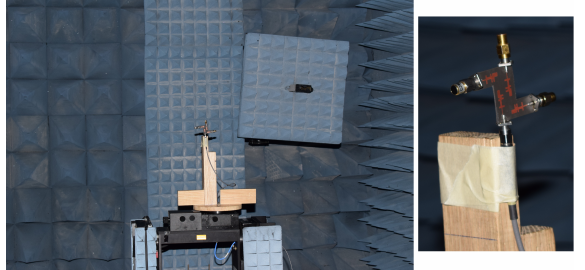
Figure 6. Proposed MIMO antenna under testing with a zoomed-in